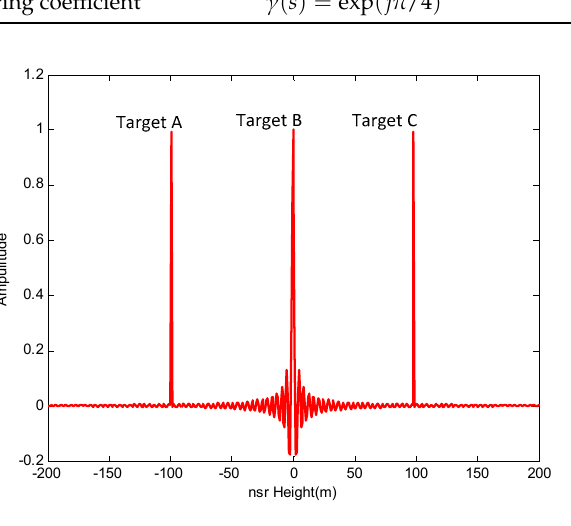
Figure 12. Simulated target.